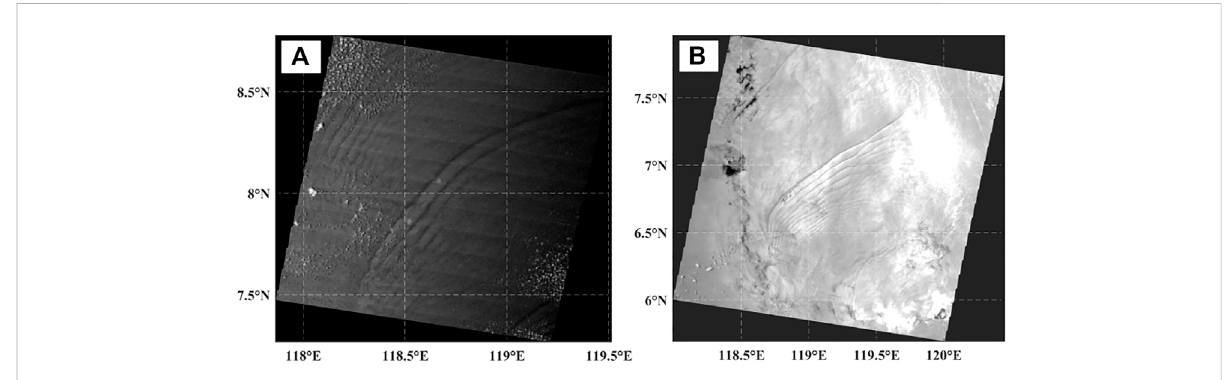
FIGURE 1 NighttimeDNBimagesofoceanicwavesoccurringintheSouthChinaSeaacquiredby (A) theNPPsatelliteon7April2020 at17:23UTCand (B) the JPSS-1 satellite on 9 March 2020 at 17:18